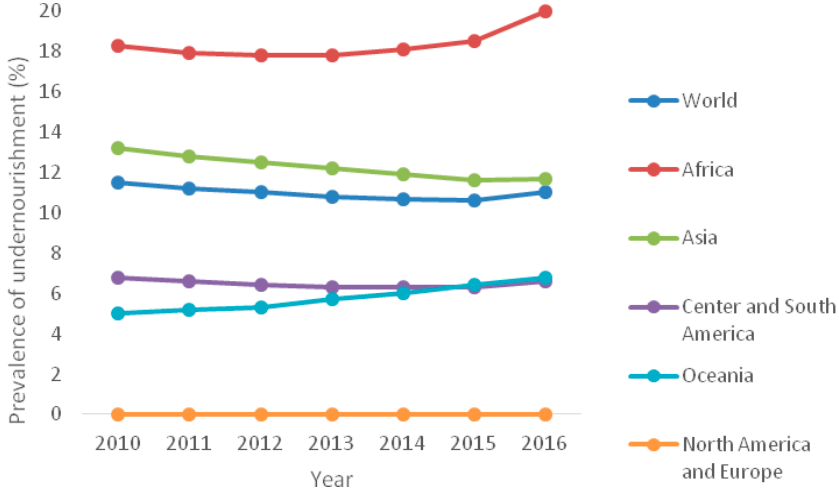
Figure 1. The prevalence (%) of undernourishment in the world by region, 2010–2016 (source: Food and Agricultural Organization, FAO [1]).